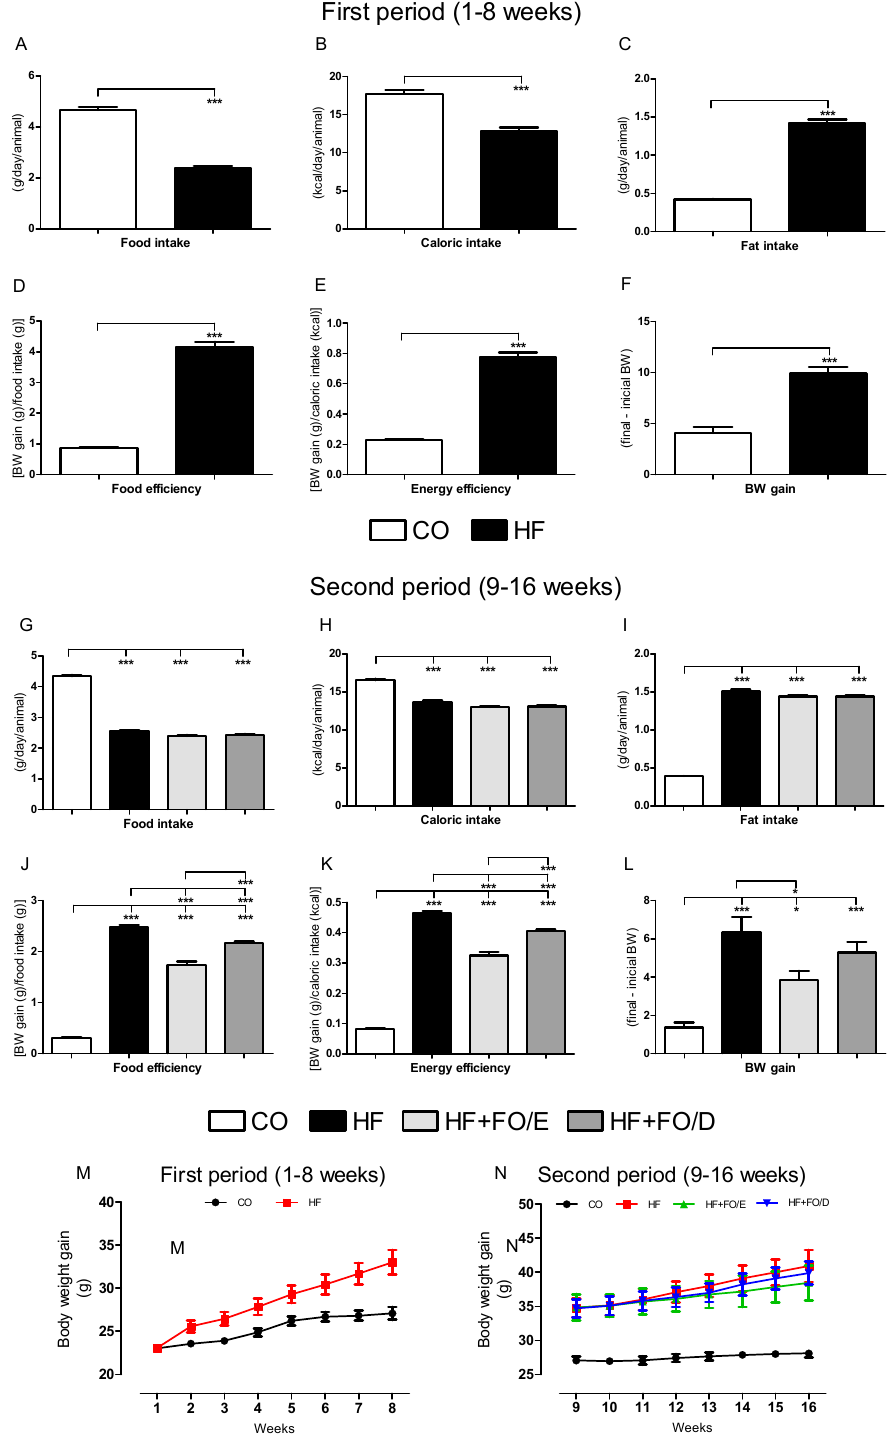
Figure 2. Food intake and body weight (BW) gain of mice fed with control (CO) or high-fat (HF) diet and treated with different compositions of fish oil (FO). During the first period, the animals received only CO or HF diet. During the second period, the diets were maintained and the animals received water (CO and HF groups), or fish oil enriched in either EPA (HF+FO/E group) or DHA (HF+FO/D group) by oral gavage three times per week. Food intake ( A ), caloric intake ( B ), fat intake ( C ), food efficiency ( D ), energy efficiency ( E ) and BW gain ( F ) in the first period. Food intake ( G ), caloric intake ( H ), fat intake ( I ), food efficiency ( J ), energy efficiency ( K ), and BW gain ( L ) in the second period, weekly body mass gain during the first period ( M ), and during the second period ( N ). Mean ± SEM. * p < 0.05, *** p <